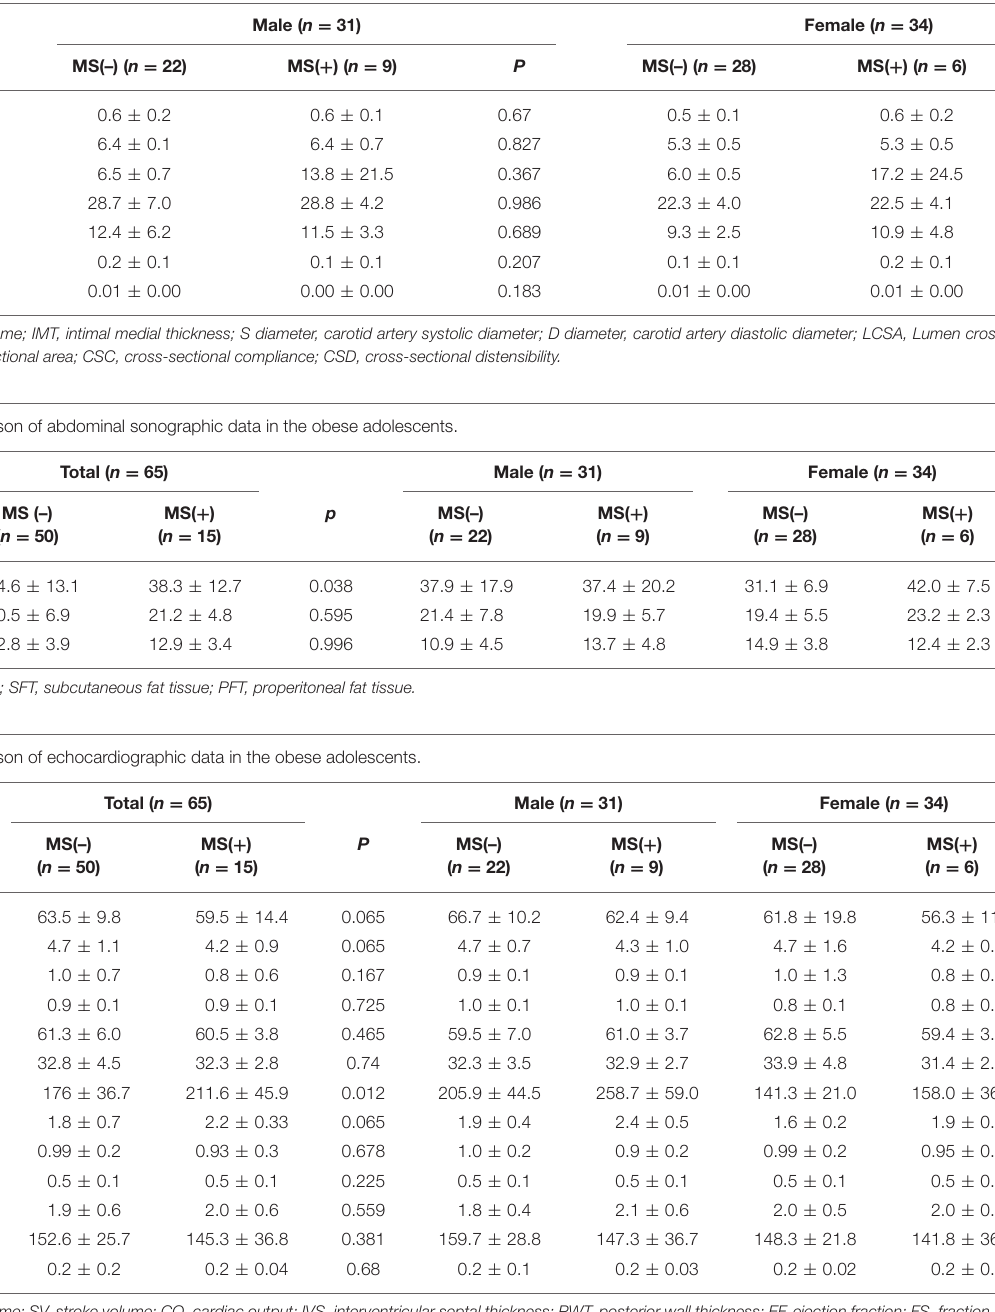
TABLE 4 | Comparison of geometrical parameters of carotid artery in the obese adolescents.